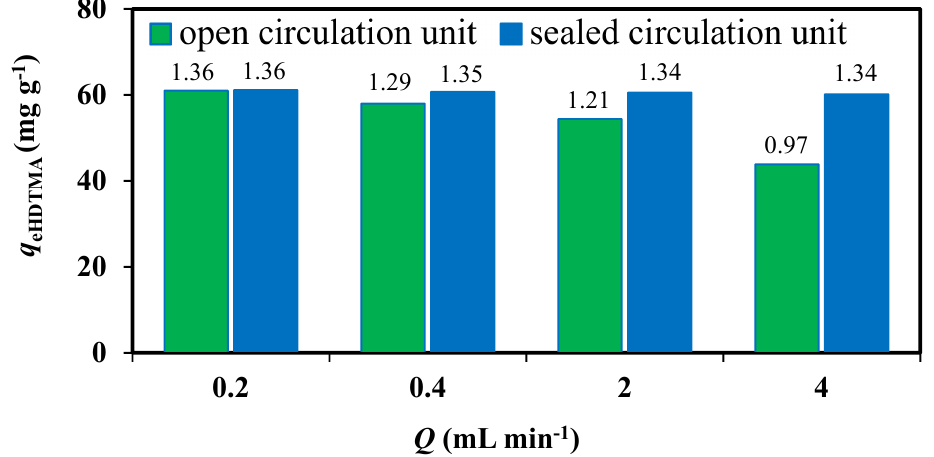
Figure 1. Influence of the type of circulation unit and surfactant solution flow rate on efficiency of CL modification. DC values over the bars. C 0 HDTMA = 1050 mg L − 1 , T = 25 ◦ C, x = 2